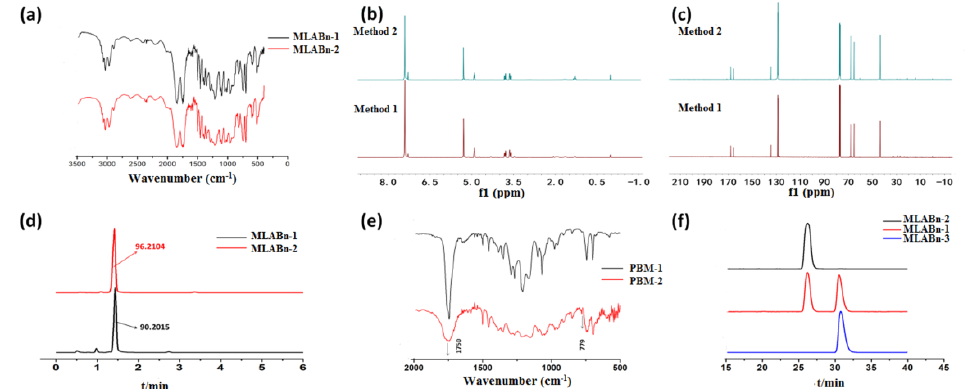
Figure 1. Synthesis routes of PMLA from aspartic acid and L/D-malic acid.